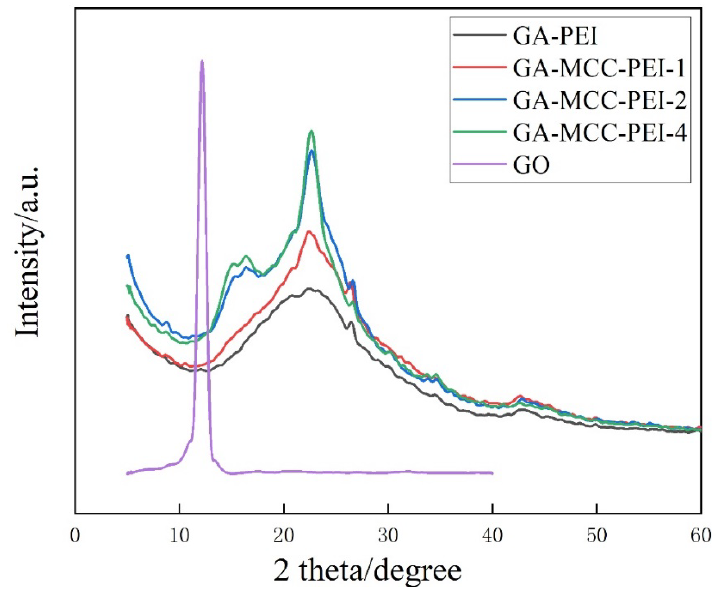
Figure 5. X-ray diffraction patterns of GO aerogel, GA-PEI aerogel, and GA-MCC-PEI-(1, 2, 4) aerogels.